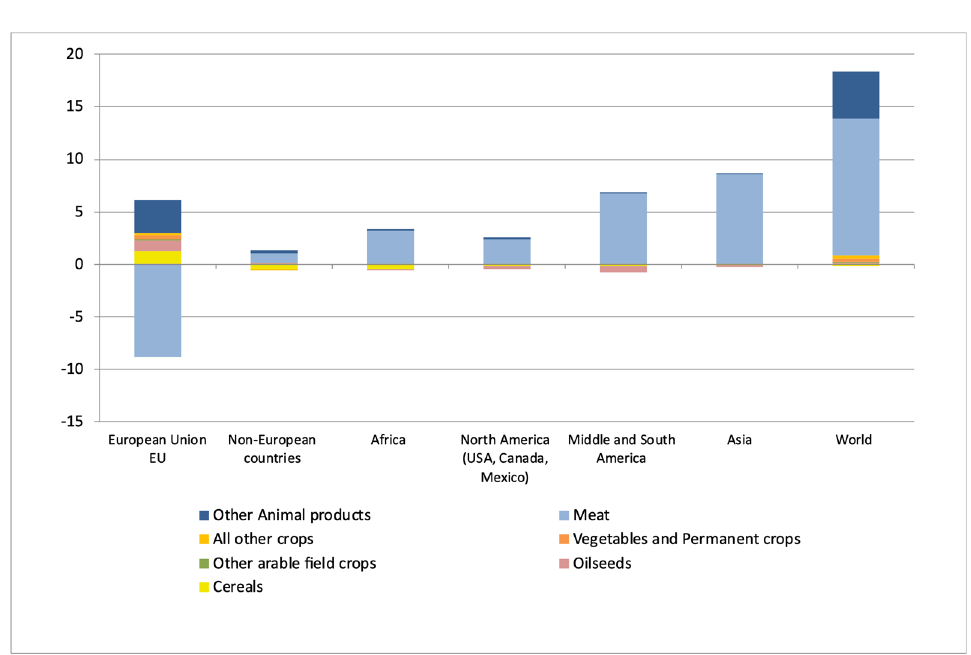
Figure 5. Greenhouse gas emissions in millions of tons of CO 2 -equivalents.